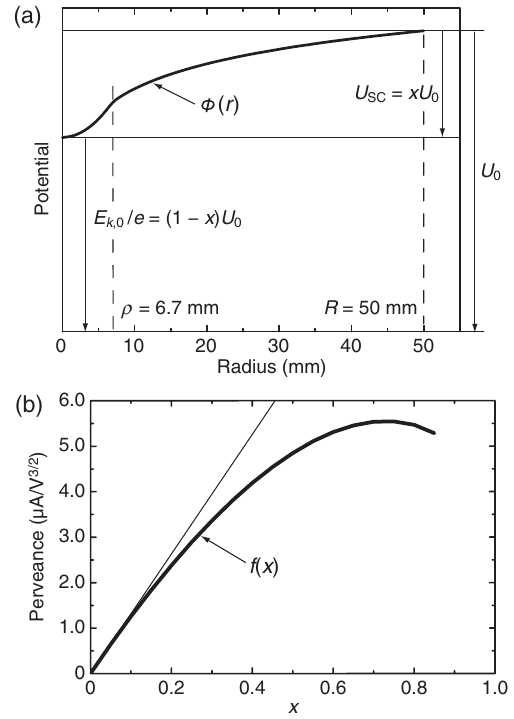
FIG. 4. (a) Electric potential distribution U ð r Þ (schematic) across the drift tube in the presence of a high perveance electron beam and definition of the quantities for describing the space charge (potentials relative to the effective source potential U (b) The beam perveance as a function of the space-charge parameter x for the geometrical parameters of the TSR electron target. Thick line: result including the electron density variation; thin line: asymptotic slope p= ð 66 μ A = V 3 = 2 Þ ¼ x= ½ 1 þ 2 ln ð R= ρ Þ(cid:1) for x ≪ 1